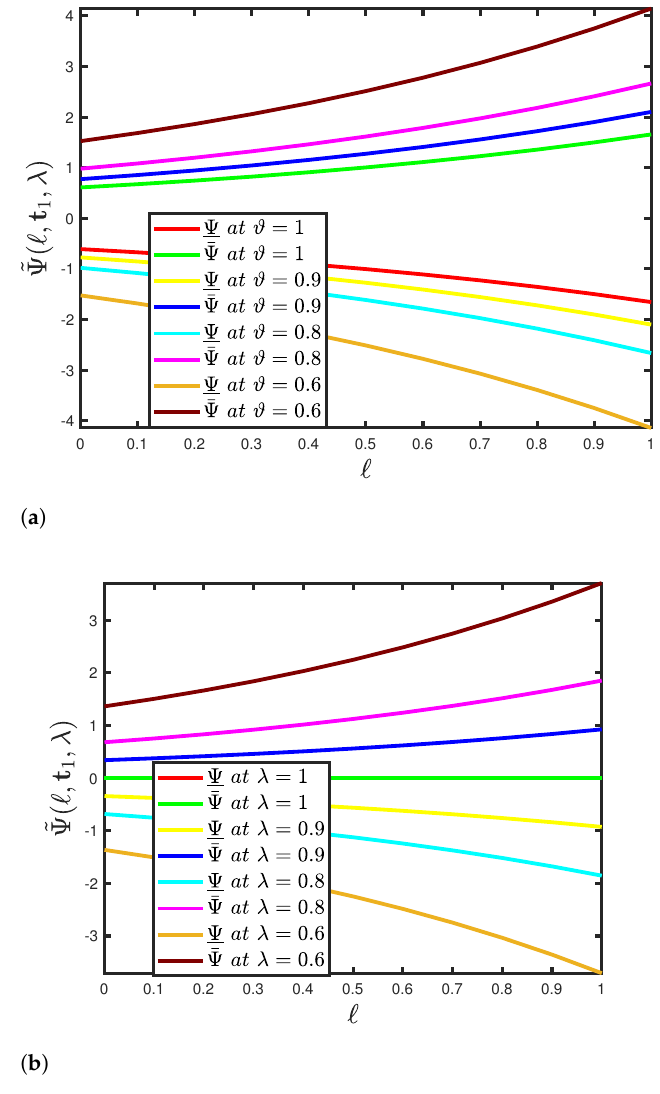
Figure 11. Two-dimensional simulation of ˜ Ψ ( (cid:96) , t 1 ; λ ) of Problem (3): ( a ) Ψ ( (cid:96) , t 1 ; λ ) and ¯ Ψ ( (cid:96) , t 1 ; λ ) when fuzzy ABC is considered to have an uncertainty parameter λ ∈ [ 0,1 ] and t 1 = 0.7; and ( b ) Ψ ( (cid:96) , t ) and ¯ Ψ ( (cid:96) , t ) when fuzzy ABC is considered to have a fractional order ϑ = 0.7 and 1 ; λ 1 ; λ t 1 =